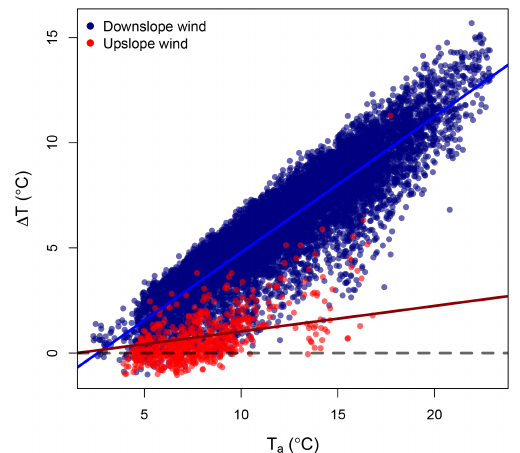
Figure 3. On glacier temperature depression ( (cid:49)T = T a − T g ) as a function of ambient air temperatures ( T a ) from ridge AWS (out- side the katabatic boundary layer). The blue line is the significant fit ( p < 0.01) for downslope/katabatic winds and the red line is the non-significant fit for upslope winds, while the dashed grey line de- marcates no temperature